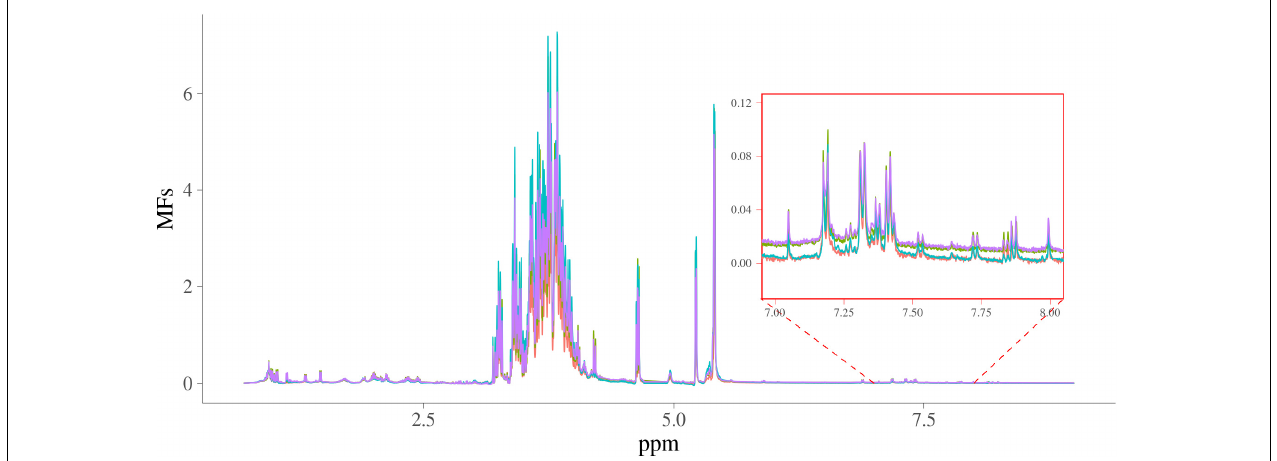
FIGURE 1 | Spectra of four random samples. x -axis is NMR chemical shift (in ppm); y -axis are the intensities of the NMR signals; four samples are in different colors.